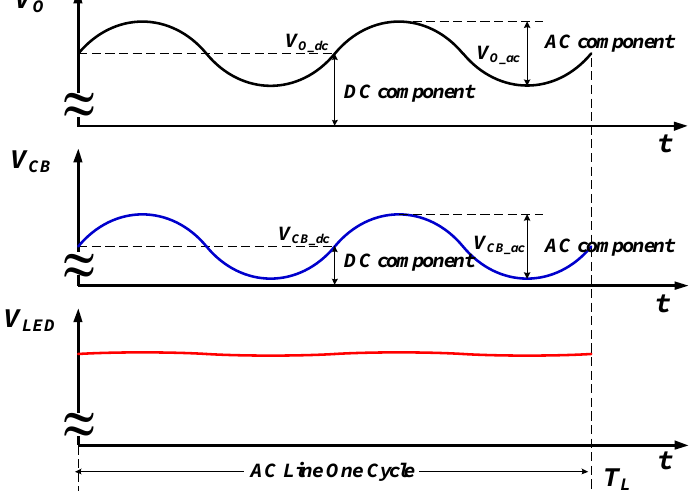
Figure 4. Conceptual waveforms of the output ripple eliminator.